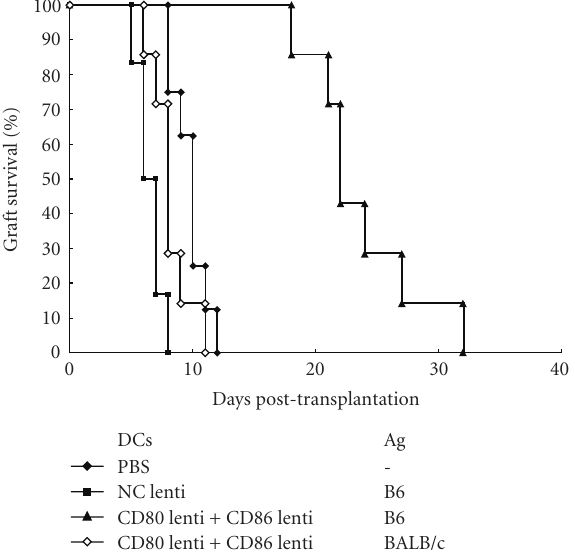
Figure 5: AlloAg-pulsed DCs in NC lenti group, or CD80 lenti and CD86 lenti group, and third party Ag-pulsed DCs in CD80 lenti and CD86 lenti group were injected into C3H mice, 7 days before the transplantation with B6 heart grafts. ∗ P < . 05 compared to other